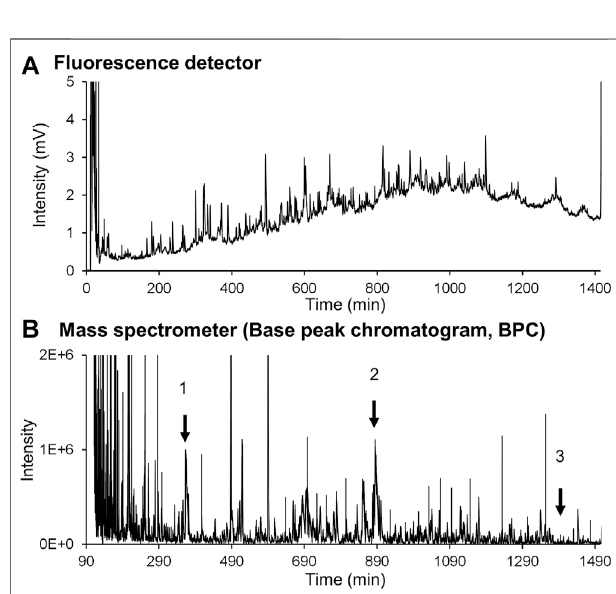
FIGURE 10 | Chromatograms of the (A) fl uorescence detector and (B) massspectrometerobtainedforDAABD-labeledhuman(K562)cell – extracted proteins over 1,400 min gradient